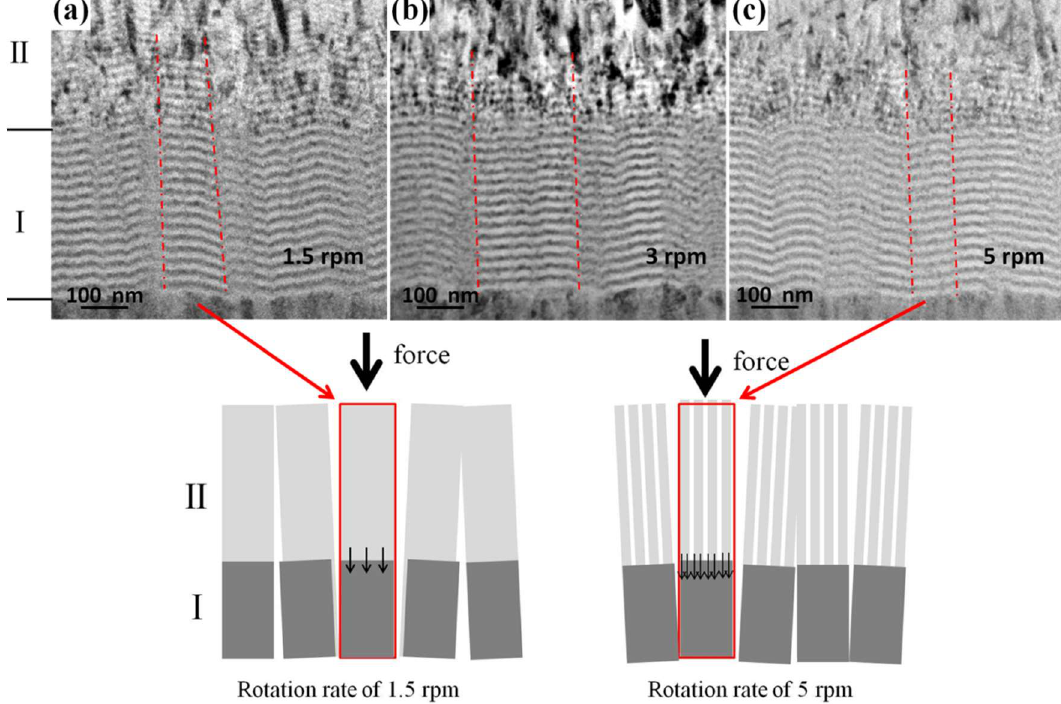
Figure 8. TEM micrographs of interlayer films beneath CrN / CrAlSiN multilayer coatings with bi-layers of various thicknesses: ( a ) 12; ( b ) 6; and ( c ) 3.2 nm.